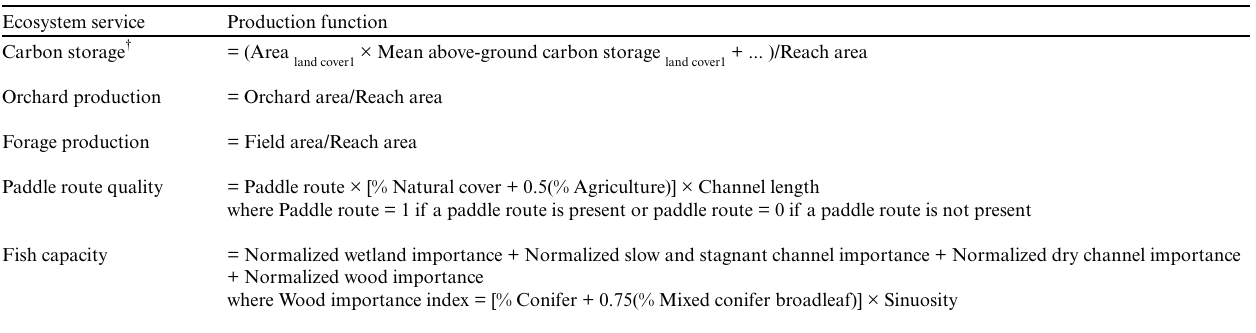
Table 1 . Production functions used to map the capacity of each river reach to provide ecosystem services.